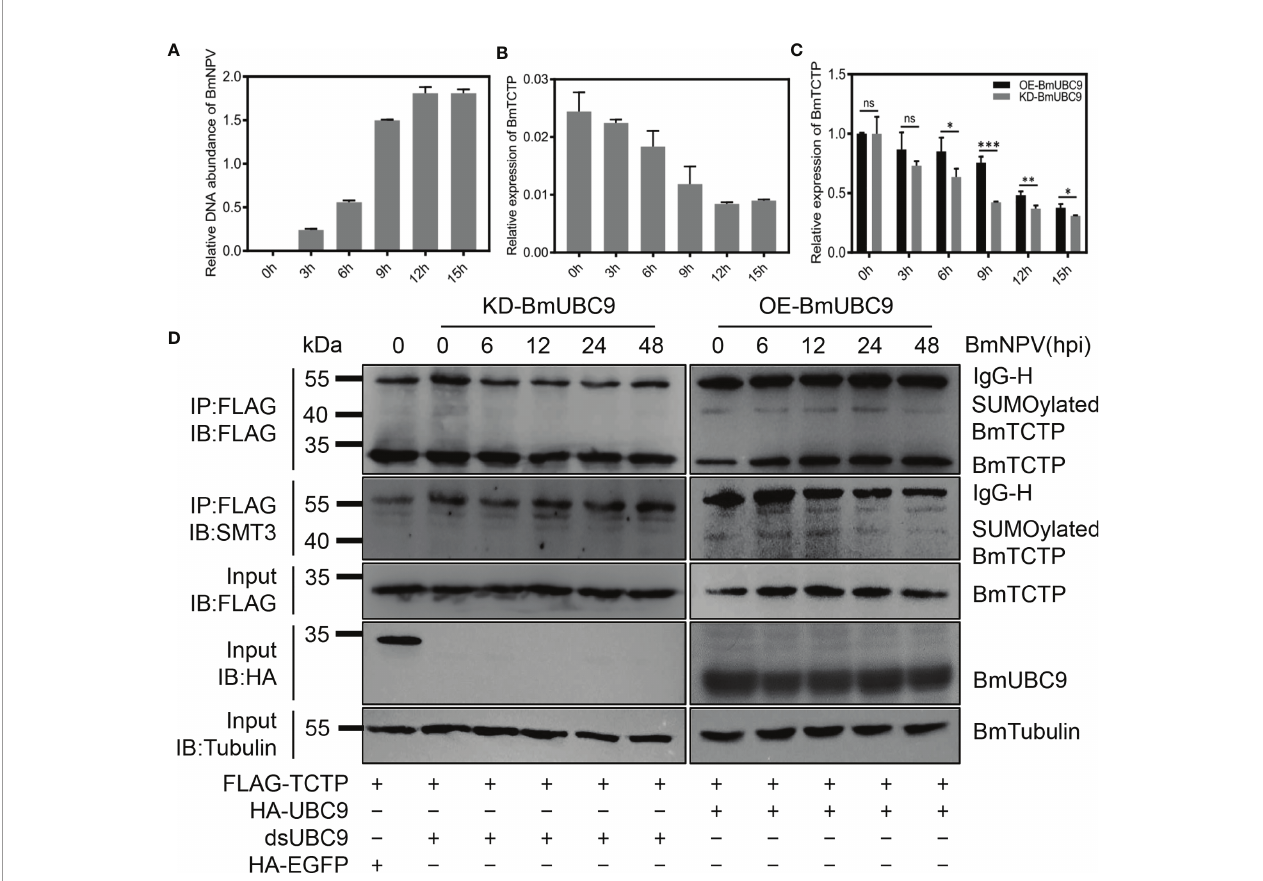
FIGURE 5 | SUMO conjugating enzyme BmUBC9 was required for the SUMOylation of Bombyx mori translationally controlled tumor protein ( BmTCTP ). (A) BmN cells infected with Bombyx mori nucleopolyhedrovirus (BmNPV) were collected at the indicated time points and used for qRT-PCR analysis of the BmNPV GP41 gene. The expression of BmGAPDH gene was used as an internal control. The data presented are the means ± SD (n = 3). (B) The expression of BmTCTP gene was analyzed by qRT-PCR following the BmNPV infection, and the BmeIF-4a was used as an internal control. The data presented are the means ± SD (n = 3). (C) The expression of BmTCTP gene was analyzed by qRT-PCR in BmUBC9 knockdown or overexpression cells following the BmNPV infection, and the BmeIF-4a was used as an internal control. The data presented are the means ± SD (n = 3). For the signi fi cant analysis: *P < 0.05, **P < 0.01, and ***P < 0.001, and ns represents no signi fi cance. (D) Plasmids as indicated were co-transfected into the BmN cells infected with BmNPV. Lysates from BmN cells were used for immunoprecipitation with anti-FLAG antibody, followed by immunoblotting with the indicated antibodies. SUMOylated BmTCTP was further determined by an anti-SMT3 antibody. IgG-L and IgG-H were the light and heavy chains of anti-FLAG